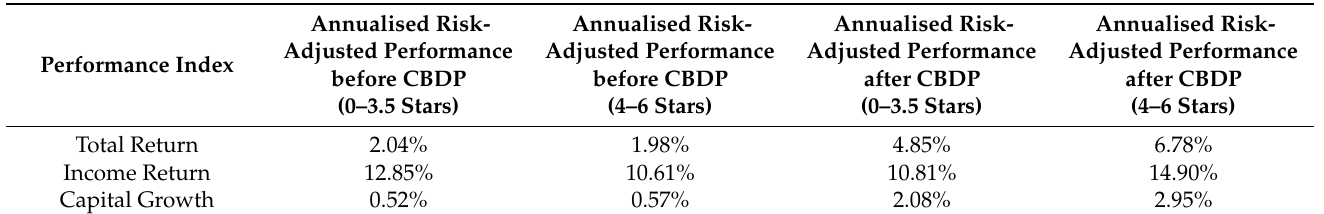
Table 3. CBD market—risk-adjusted performance non-green (0–3.5 stars) vs. green (4–6 stars).